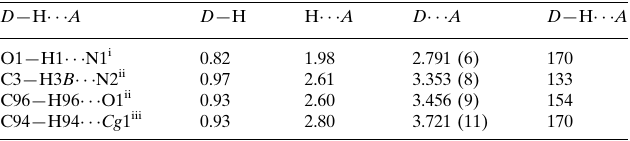
Hydrogen-bond geometry (A˚ , (cid:4) ). Cg 1 is the centroid of the C31–C36